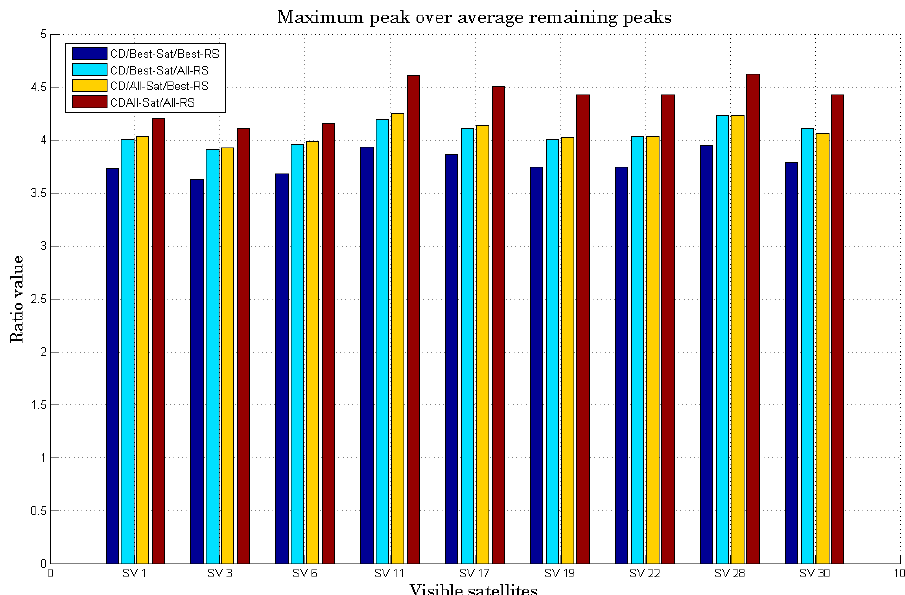
Figure 8. Ratio of maximum peak/average of remaining peaks of all 4 CD algorithms.